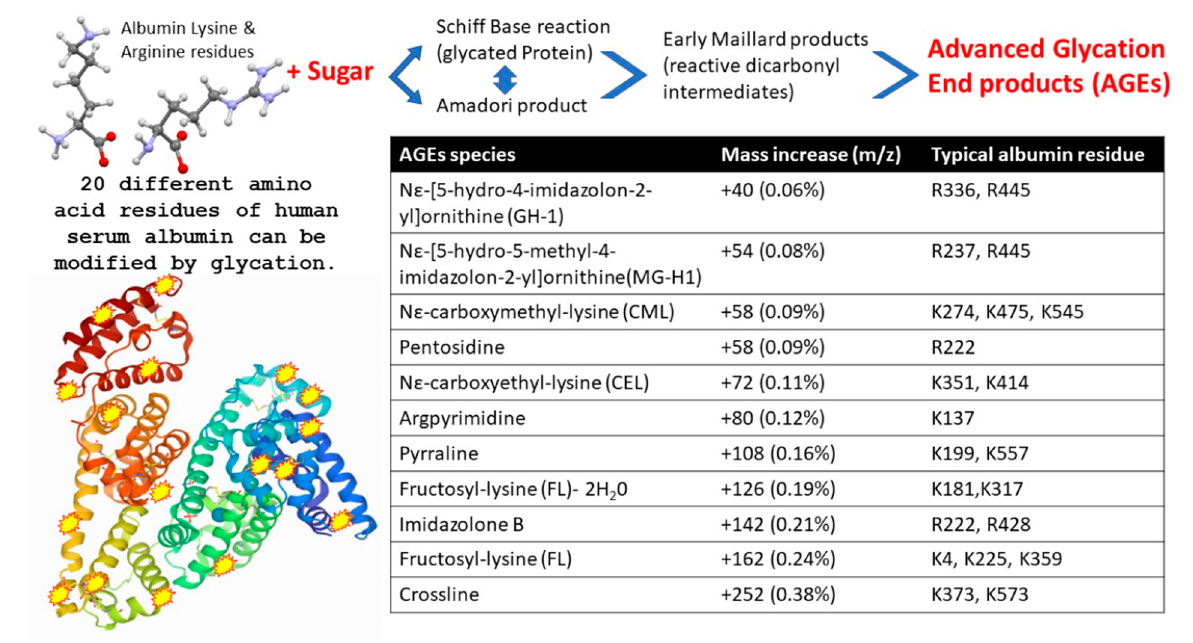
Figure 4. Illustration of advanced glycation end product (AGE) as a result of human serum albumin Schiff base/Amadori/Maillard reactions with blood circulating reducing monosaccharides (glucose and fructose), resulting in modification to exposed lysine and arginine amino acid side chains. The molecular mass effects of these AGE reactions on specific HSA residues are also detailed.